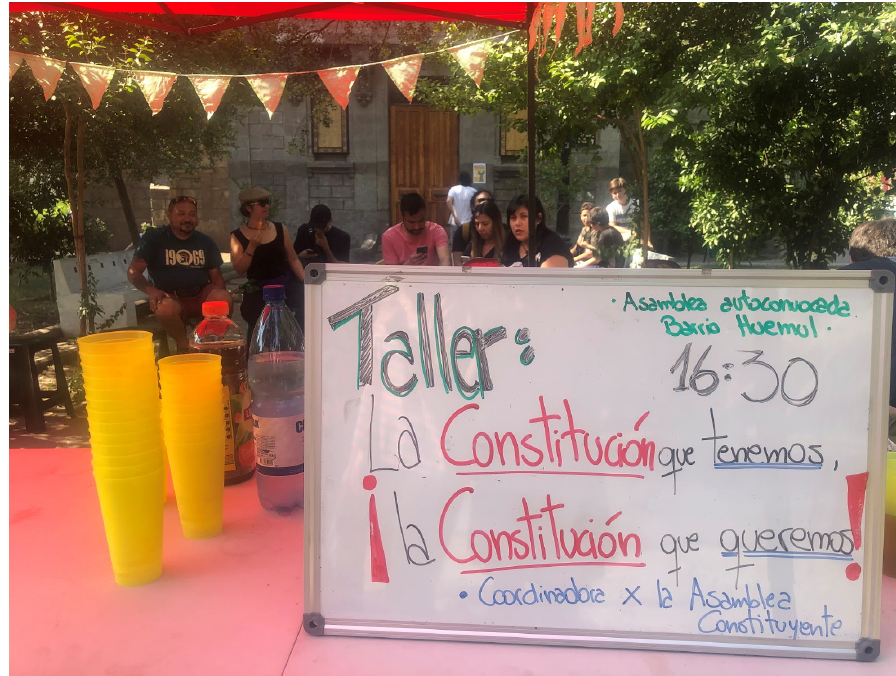
23 November 2019 – Plaza Huemul – workshop organised by the Huemul Assembly on